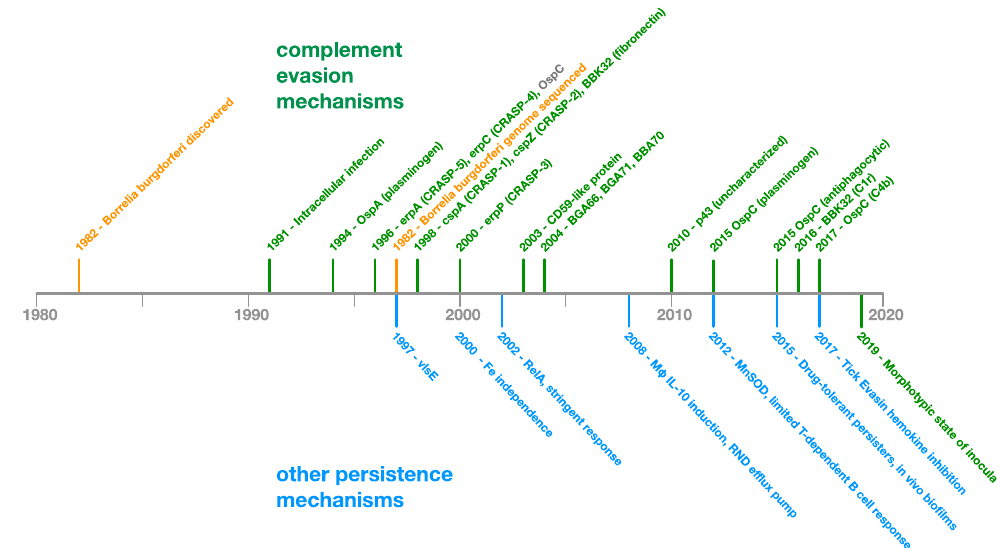
Figure 5. Borrelia Immune Evasion and Persistence Research Timeline—A selection of novel immune evasion and persistence discoveries since 1982.